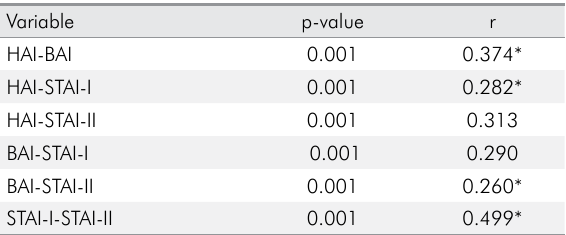
Table 2. The correlation between HAI, BAI, STAI-I, STAI-II level of